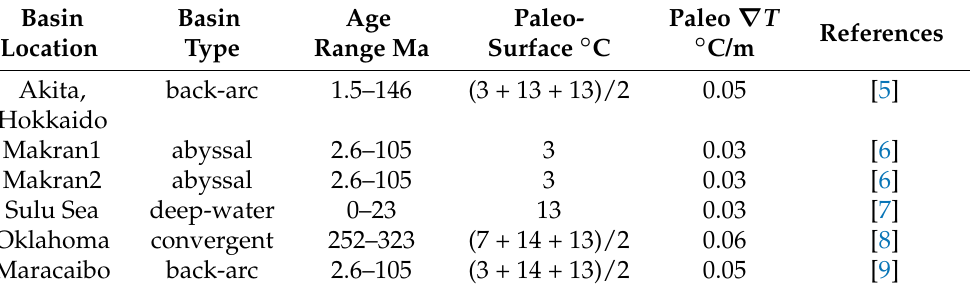
Table 1. Description and initial provisional parameters for wells.